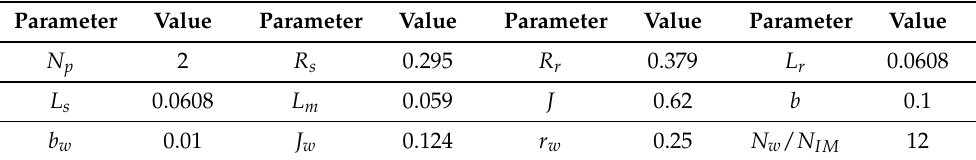
Table 1. Nominal parameters of the winch and IM